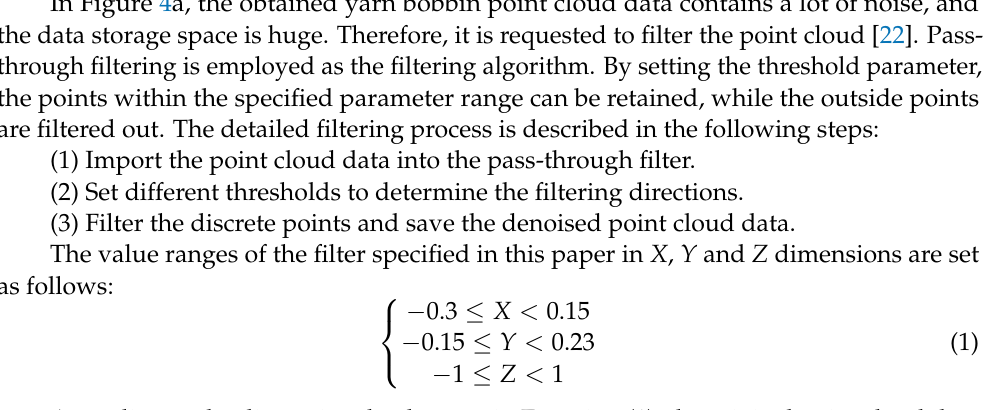
Figure 4. Mapping results: ( a ) point cloud of yarn bobbin; ( b ) denoised point cloud.